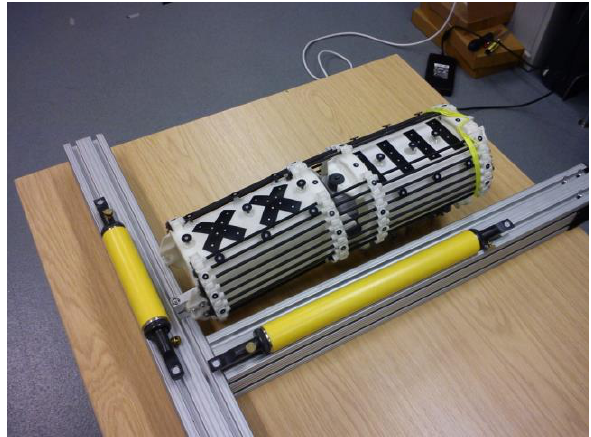
Figure 7. DSLR coordination of the Sensor Platform Target Constellation